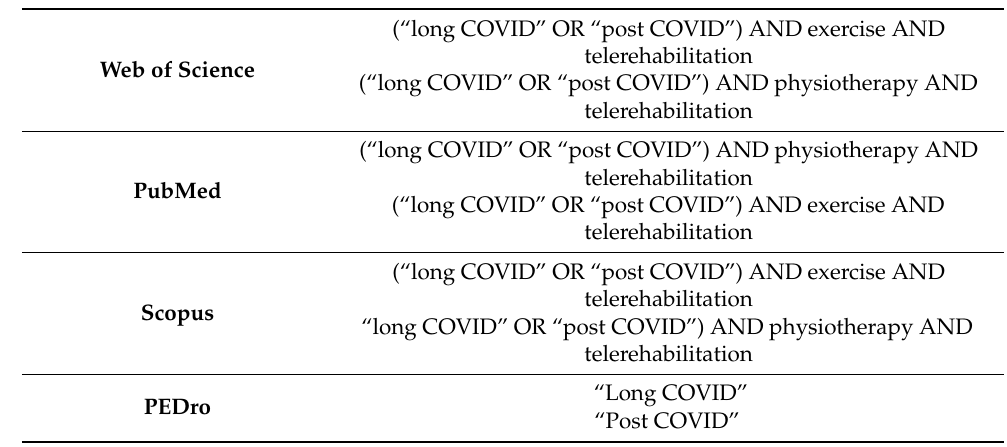
Table 2. PICOS Question. Population Post COVID-19 patients with symptoms. Different methods of therapeutic exercise involving the use of Intervention telerehabilitation. Comparison Difference between initial assessment and final assessment. Any physical parameter, scale, or test. Validated for Outcome evaluation purposes. Study Design Randomized controlled studies or longitudinal